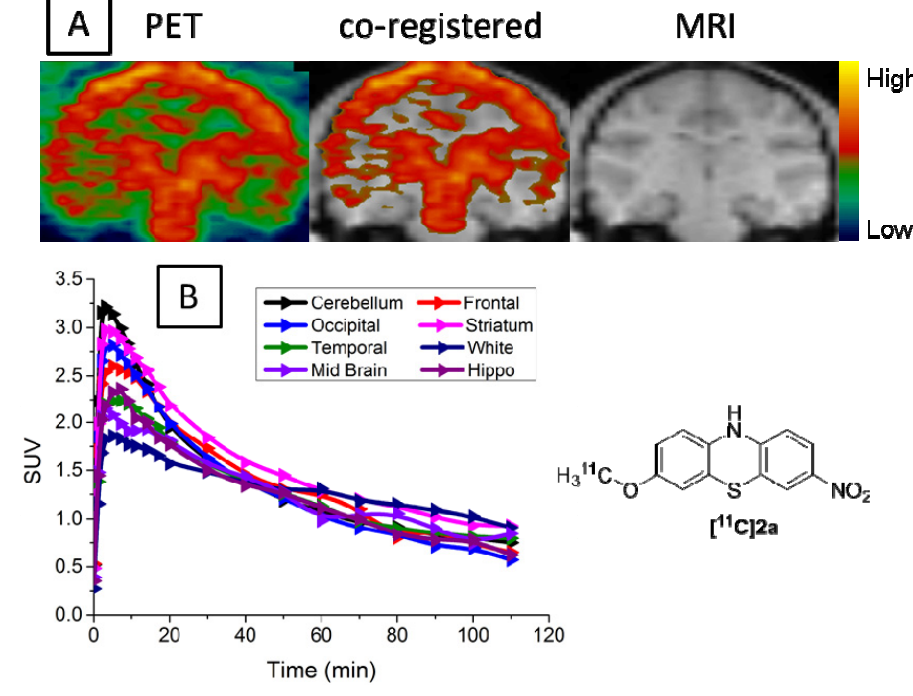
Figure 3. In vivo microPET brain imaging studies of [ 11 C] 2a in cynomolgus macaque. ( A ) PET image ( B ) time-activity curves. SUV, standardized uptake